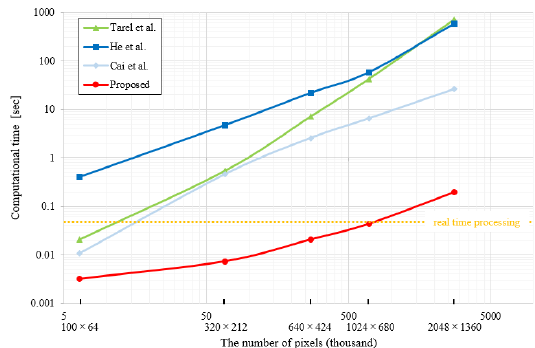
Figure 10. Comparison of computation time for each image size and each